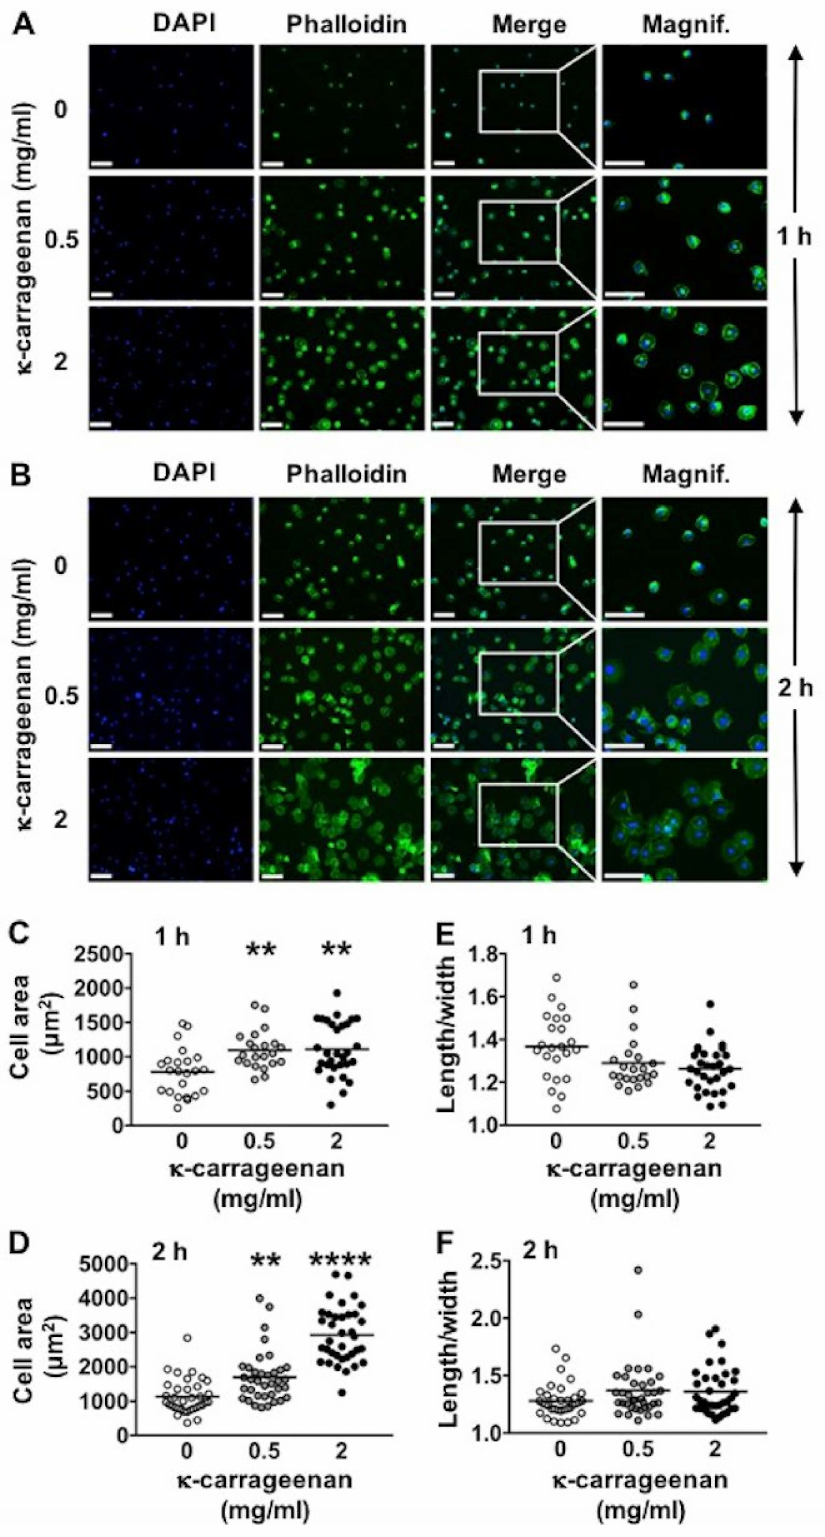
Figure 2. K-carrageenan enhanced the spreading of adhered MC3T3-E1 pre-osteoblasts at 1